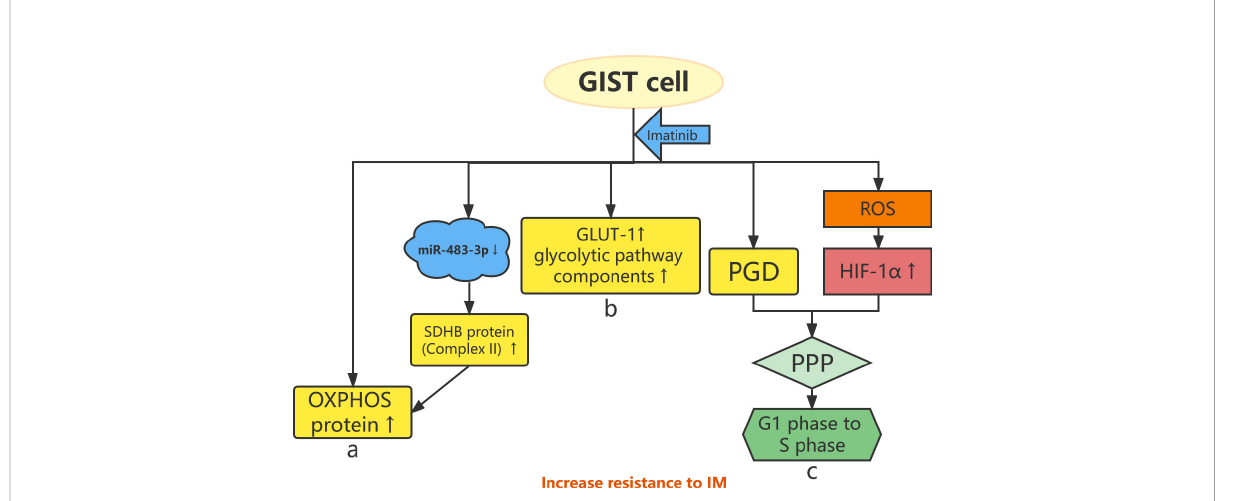
FIGURE 1 Abnormal energy metabolism and resistance to imatinib. (A) OXPHOS protein expression is increased in IM-resistant GIST cells, and IM speci fi cally increases the expression of complex II (SDHB) protein by downregulating miR-483-3p. (B) GLUT-1 and glycolytic pathway components increase in IM-resistant GIST cells. (C) The HIF-1 a – PGD – PPP axis and IM-induced ROS stimulate GIST cells from the G1 phase to the S phase, leading to drug